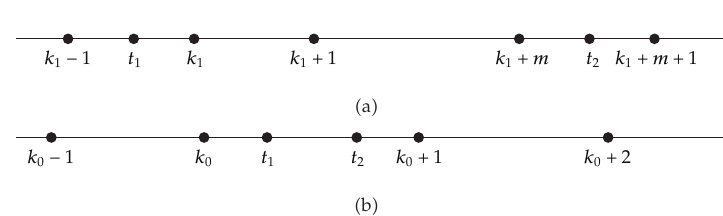
Figure 1: The relative position of t 1 and t 2